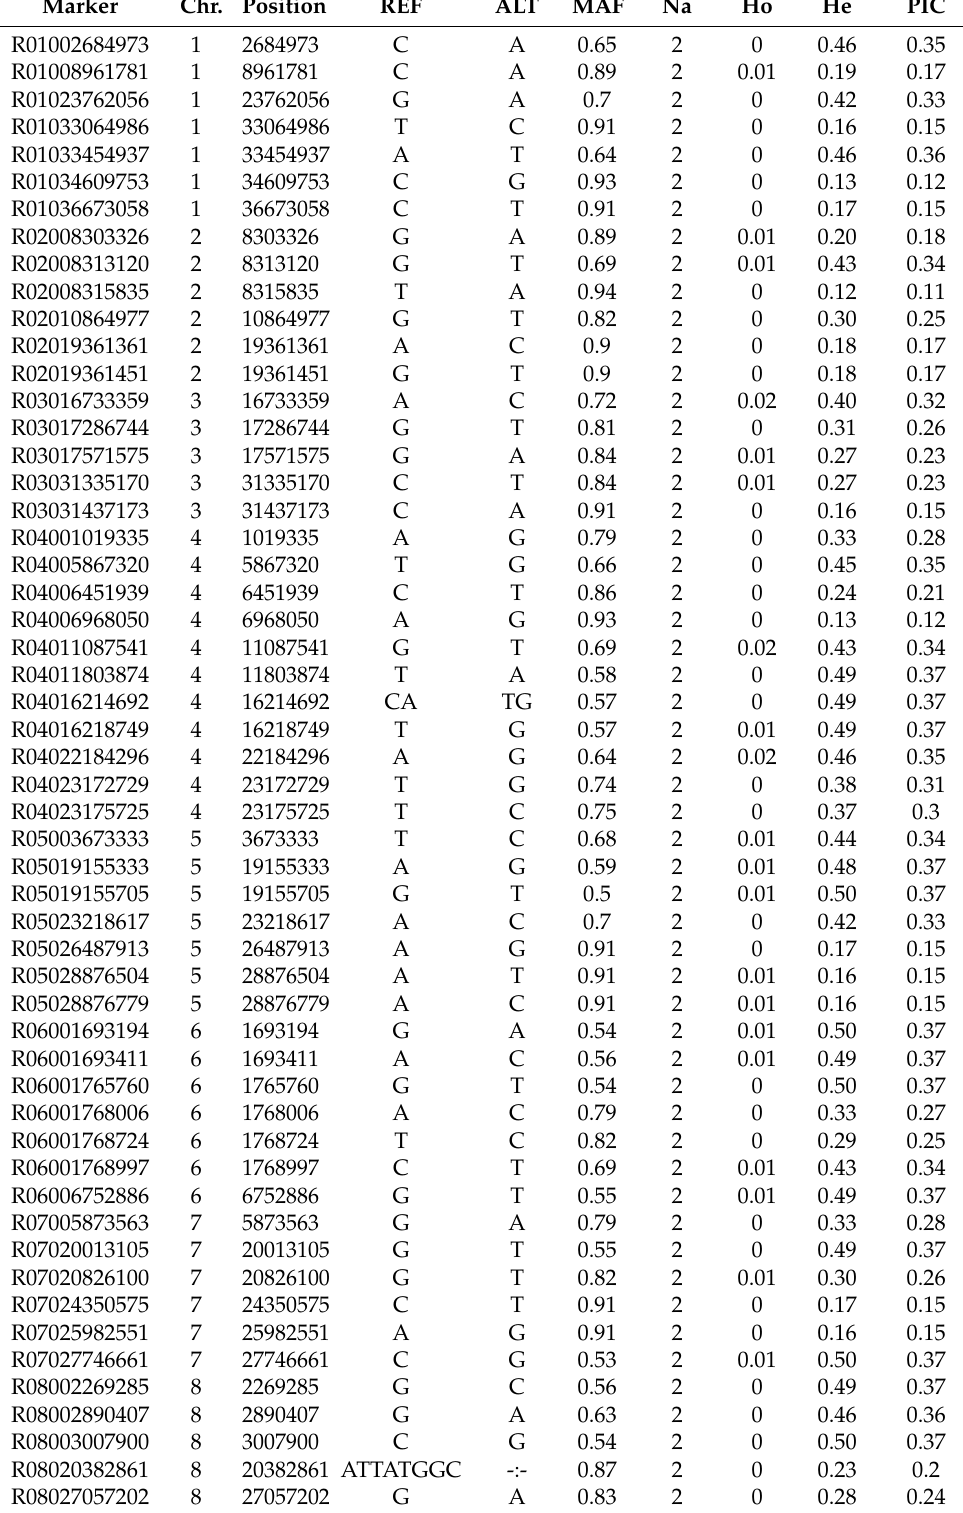
Table 1. The polymorphism levels detected using the major allele frequency (MAF), number of different alleles ( Na ), number of effective alleles ( Ne ), observed heterozygosity ( Ho ), expected het- erozygosity ( He ), and Polymorphic Information Content (PIC) based on the SNP markers used in the